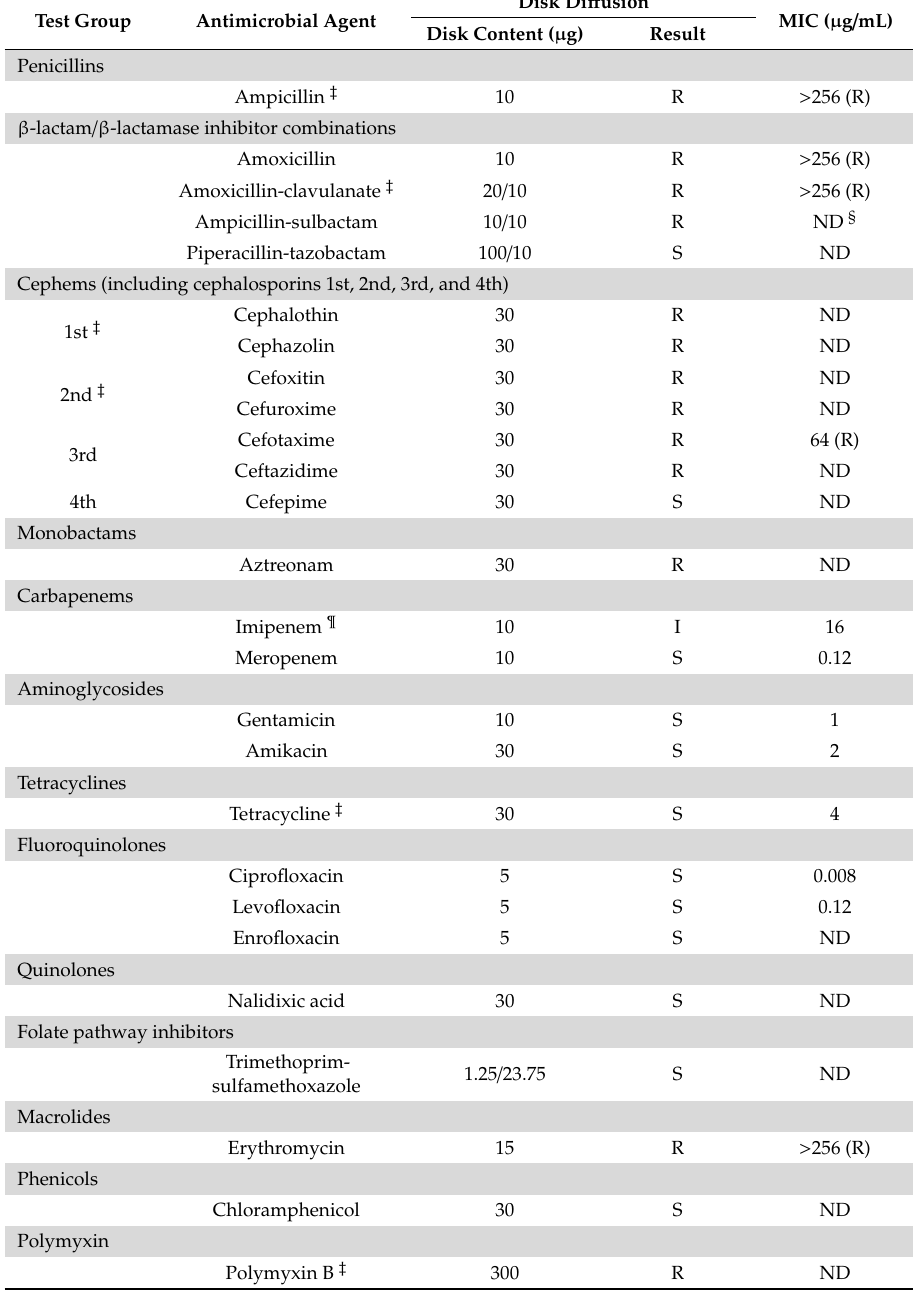
Table 1. Antibiotic resistance profile of Morganella morganii strain KC-Tt-01 †